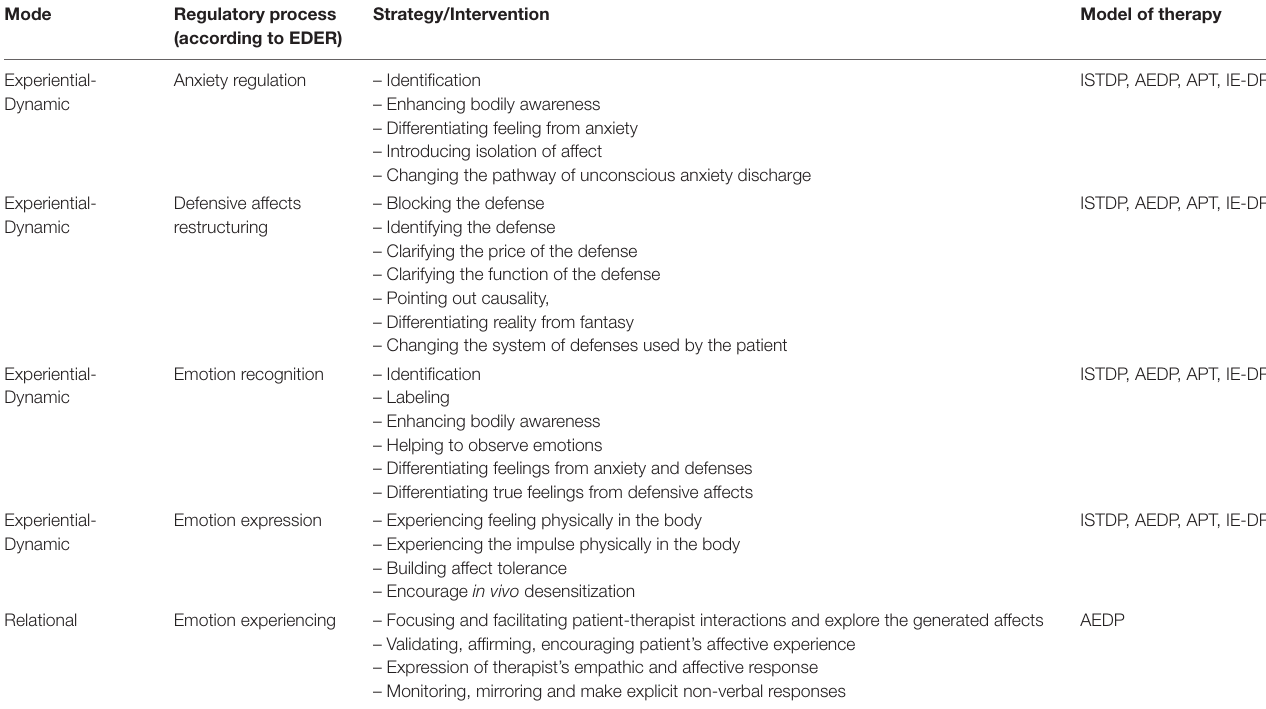
TABLE 3 | Experiential-dynamic techniques for regulating